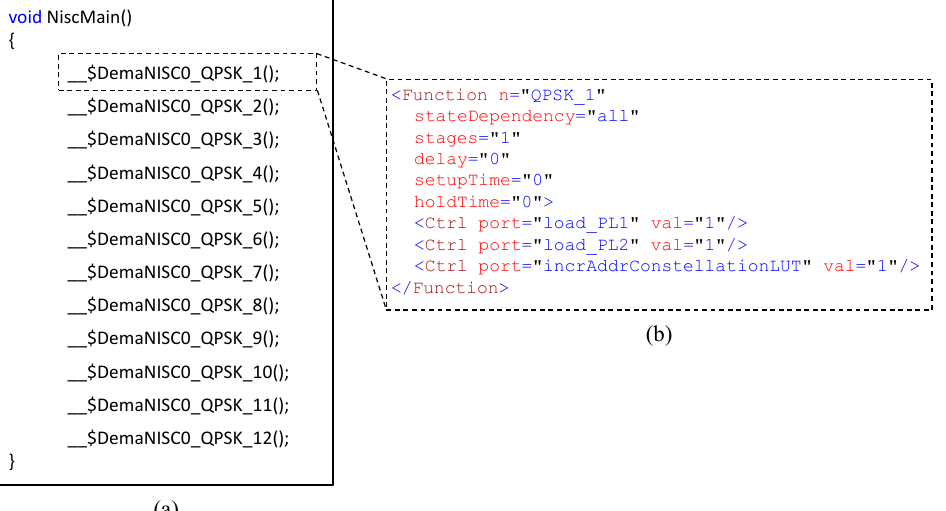
Figure 10. ( a ) List of C definitions related to pre-bound functions defining the functionality of the DemaNISC module and ( b ) GNR description of the pre-bound function “ QPSK1 ”, which declares the control values that should be applied at the first step of demapping for QPSK modulation